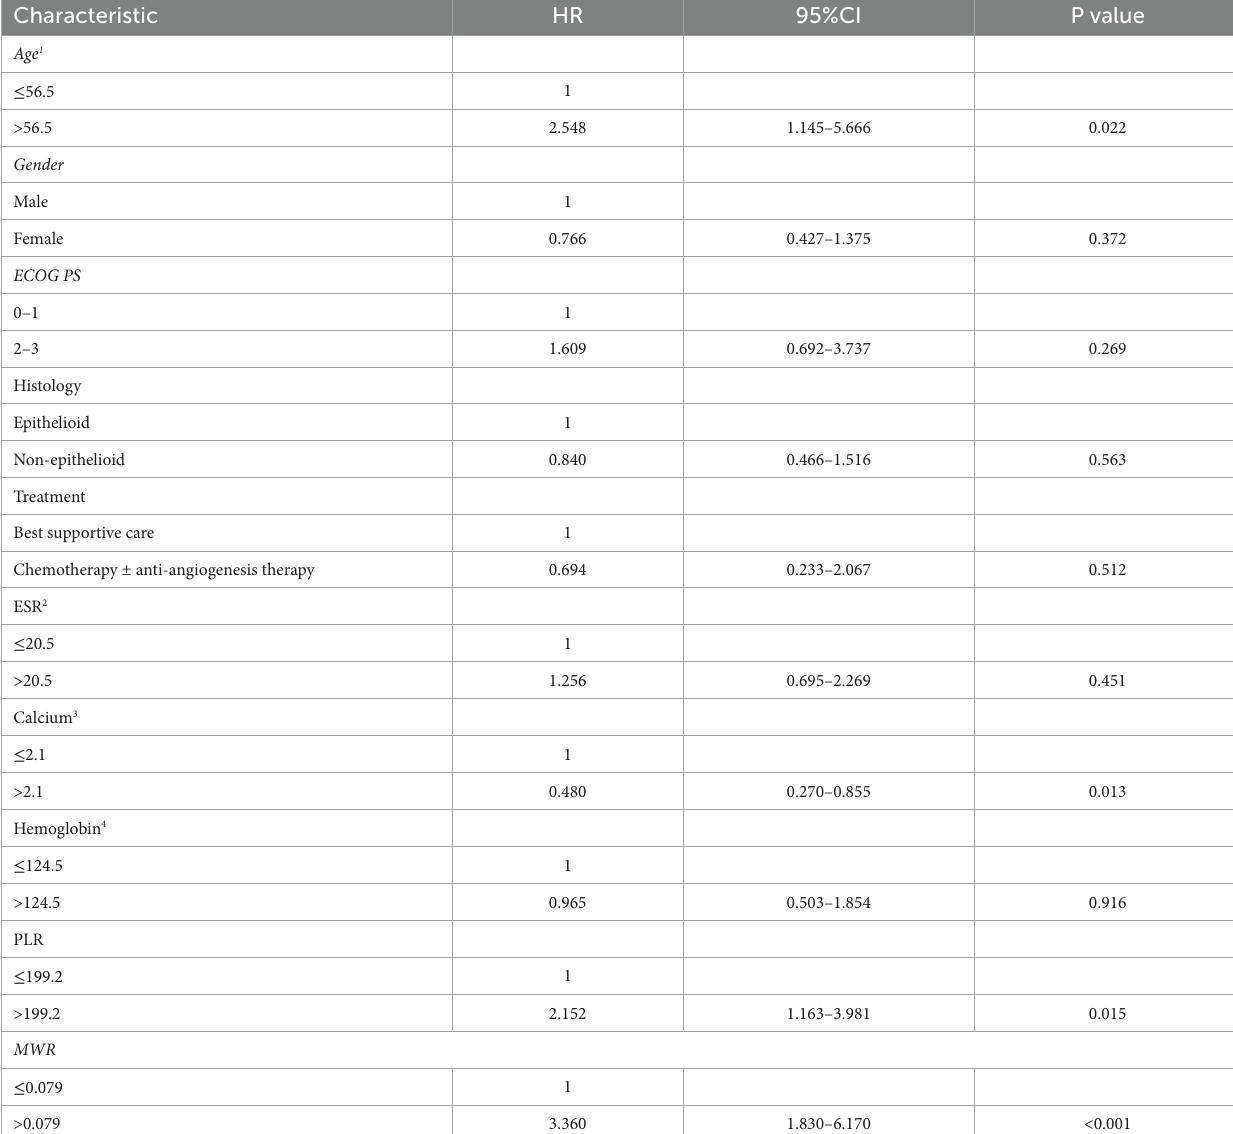
TABLE 3 Multivariable Cox regression analyses between baseline characteristics, laboratory variables, and OS of malignant pleural mesothelioma patients.